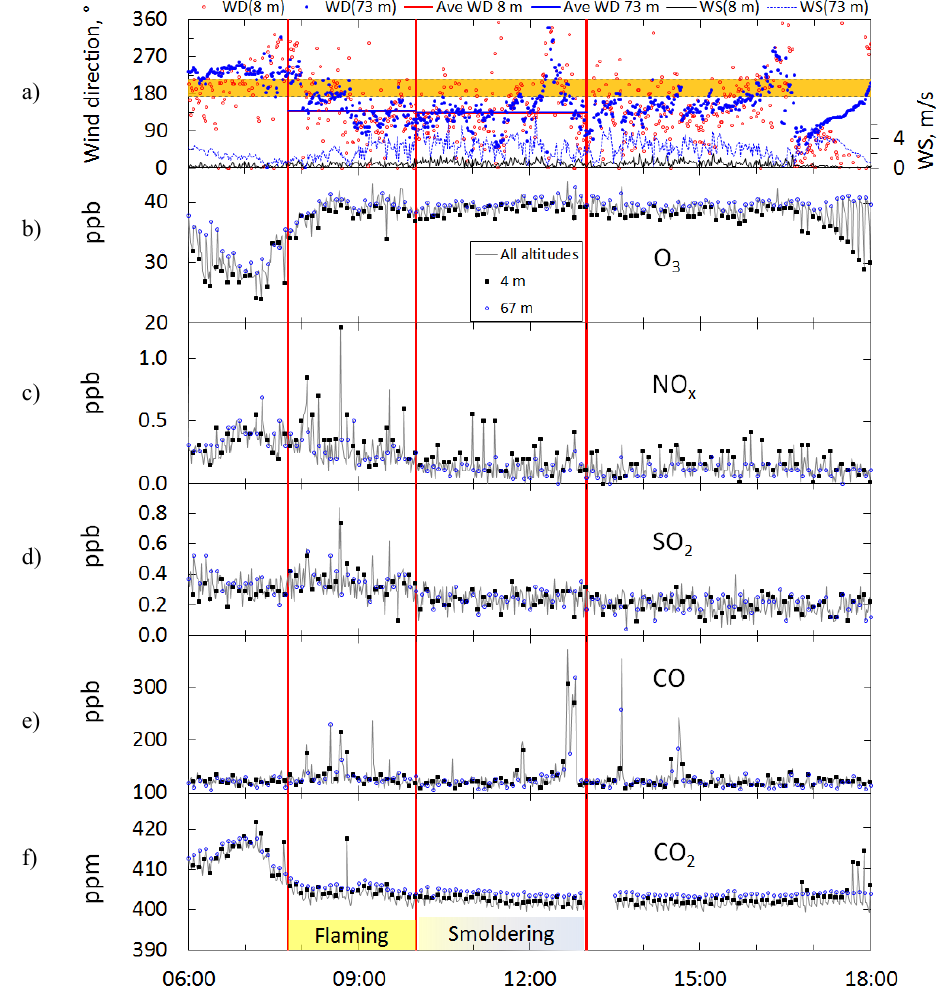
Fig. 3. Selected data obtained from the SMEAR II mast during the burning day at a 1min time resolution. (a) Wind direction and speed at two altitudes: 8m and 74m above ground level. The dark yellow shading indicates the wind direction sector that would bring smoke from the fire to SMEAR II. (b–f) Concentrations of selected trace gases measured at all altitudes (grey line) and at the lowest and the highest trace gas sampling levels, that is 4m and 67m above ground (black square and blue circle, respectively). The temporal spacing of the trace gas data at each height is 6min. The red vertical lines indicate the start and end of the flaming and clear smoldering